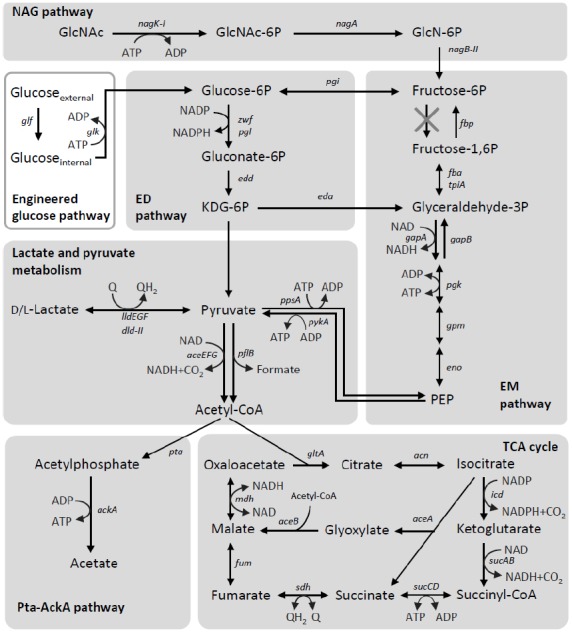
Carbon-catabolic pathways in S. oneidensis MR-1. The pathways are depicted based on findings reported in the literature (Scott and Nealson, 1994; Yang et al., 2006; Tang et al., 2007a,b; Pinchuk et al., 2009; Choi et al., 2014). Intrinsic catabolic pathways are shown in shaded boxes, while an engineered pathway is depicted in a white box. Q, oxidized form of ubiquinone or menaquinone; QH2, reduced form of ubiquinone or menaquinone.